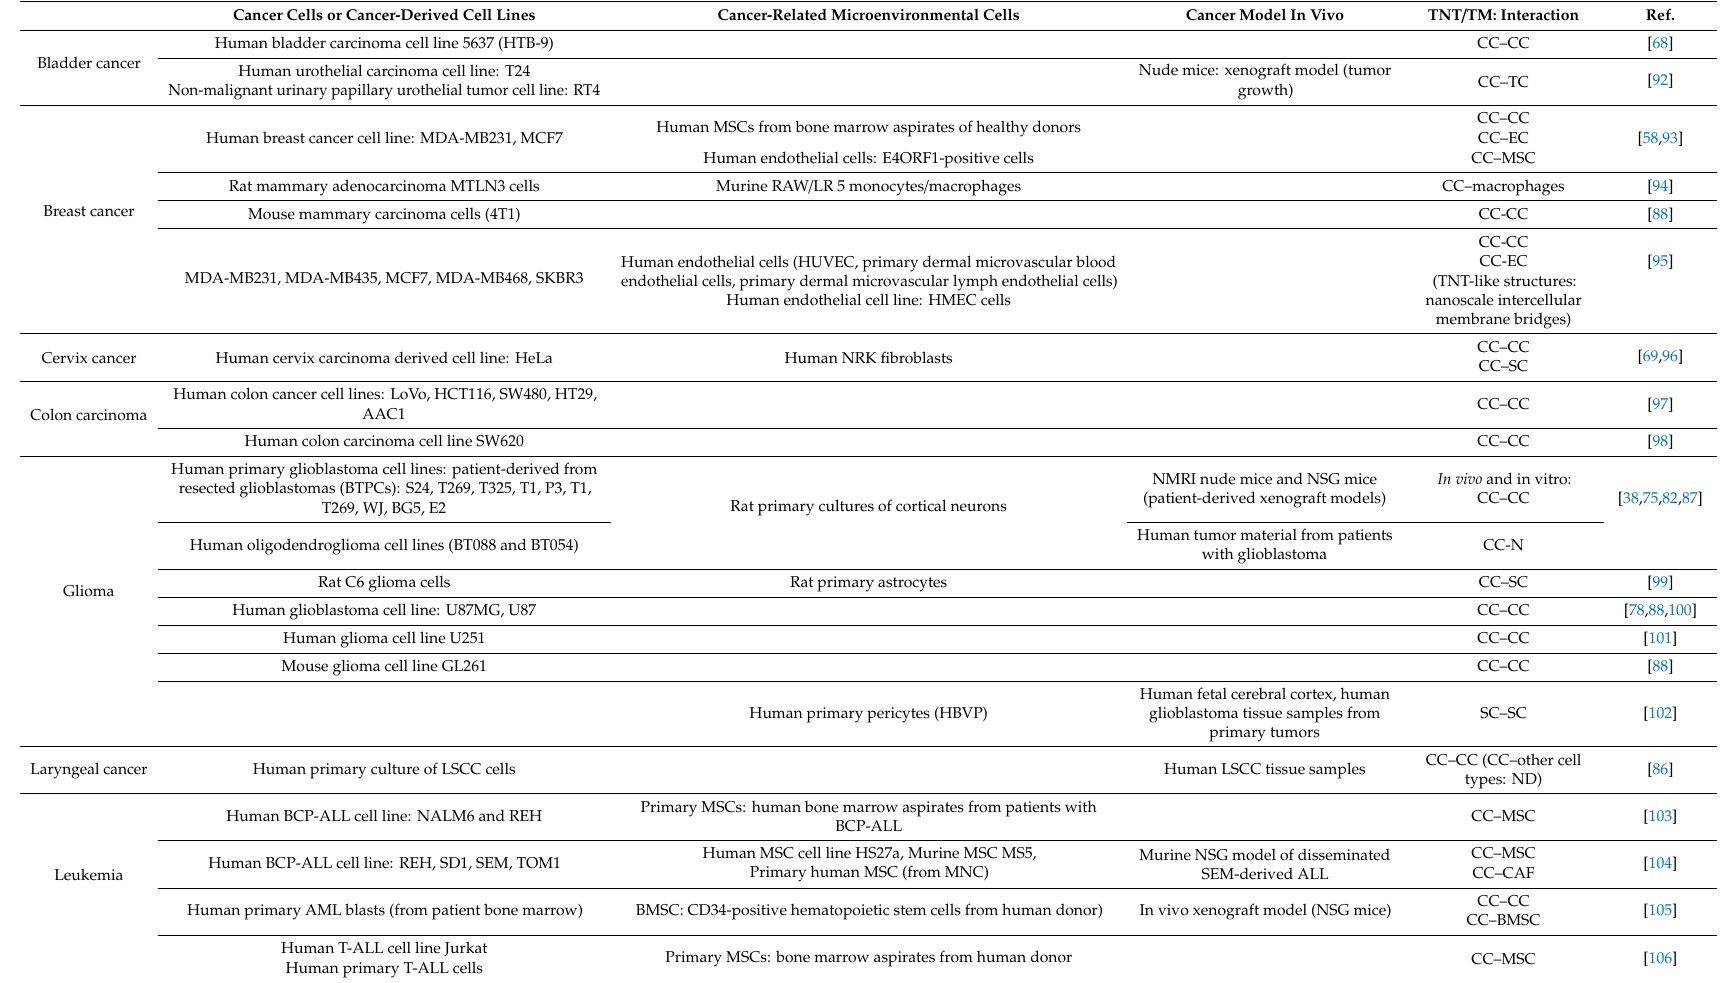
Table 1. Overview of the occurrence of TNTs / TMs in cancer cell